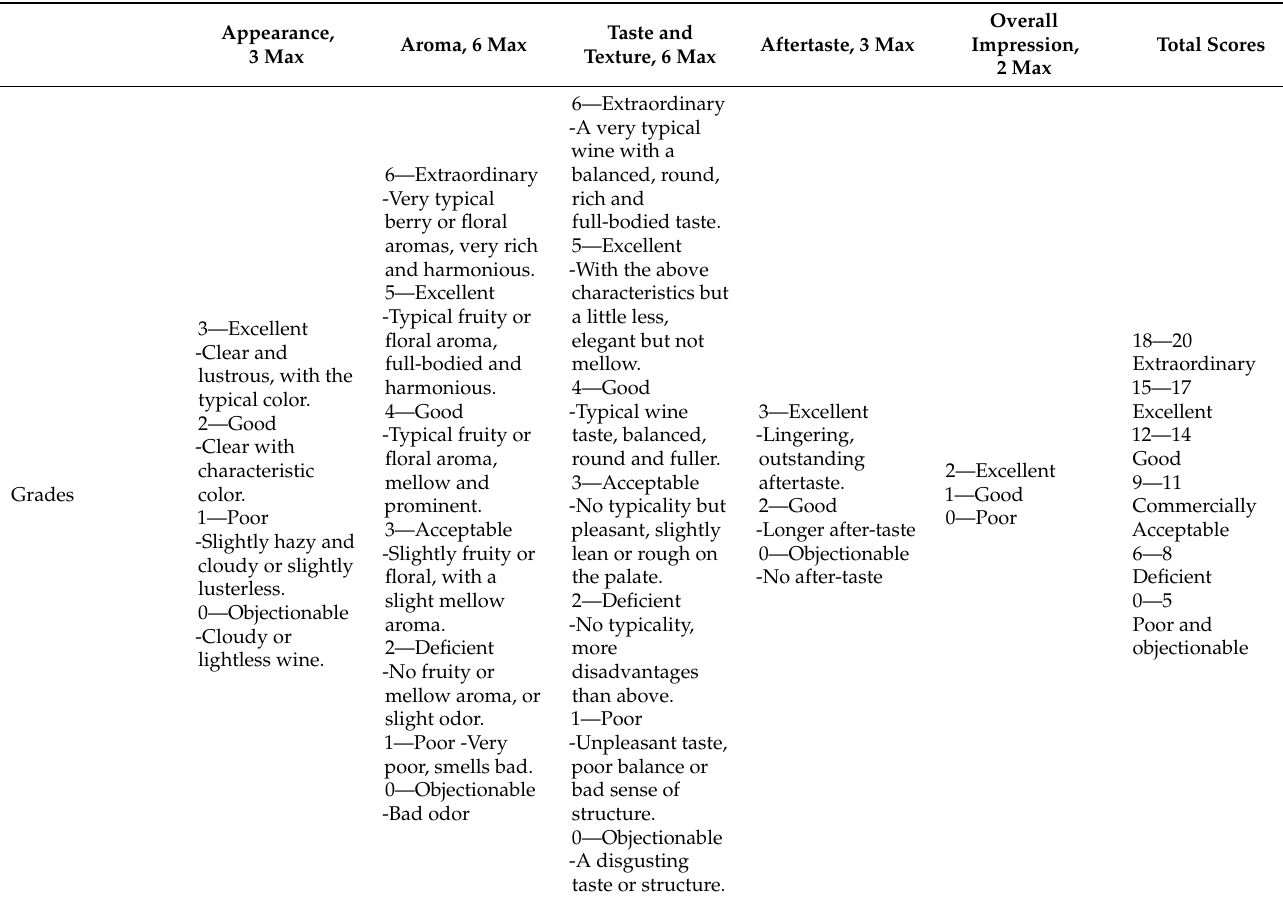
Table 1. Evaluation of wine sensory